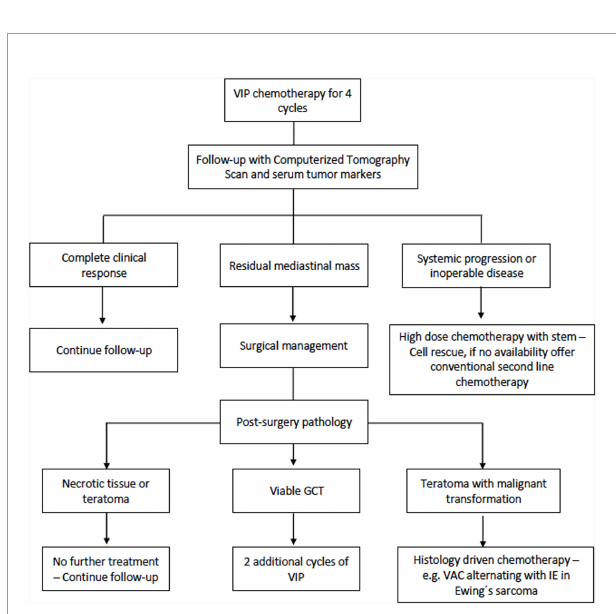
FIGURE 2 | Subsequent management of mediastinal non-seminomatous germ cell